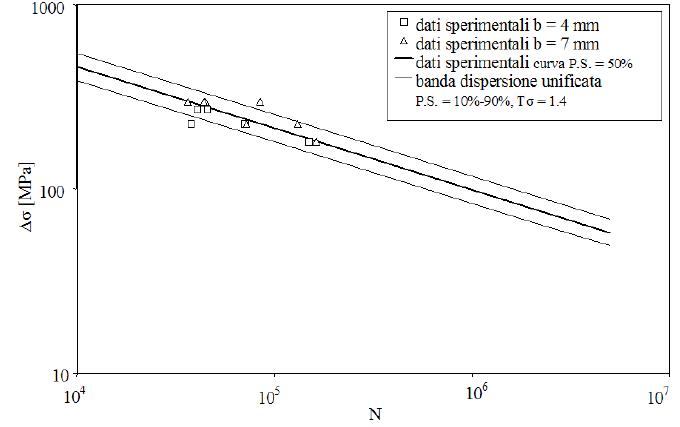
Figura 7: Banda di dispersione unificata applicata ai risultati sperimentali.